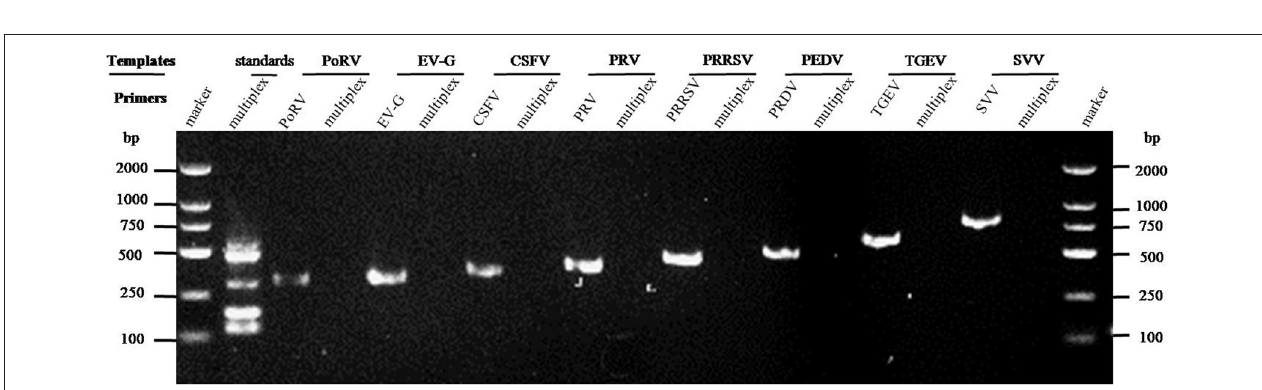
FIGURE 3 | Sensitivity analysis of the monoplex and multiplex PCR method established in this study. Equal amounts of standards of each genotype (10 ng − 0.1 pg) were added to the single or multiplex PCR mixture and amplified at the optimized thermo cycle condition. (A–E) Monoplex PCR sensitivity analysis of PAstV1, PAstV2, PAstV3, PAstV4, and PAstV5, respectively. (F) Multiplex PCR sensitivity analysis.